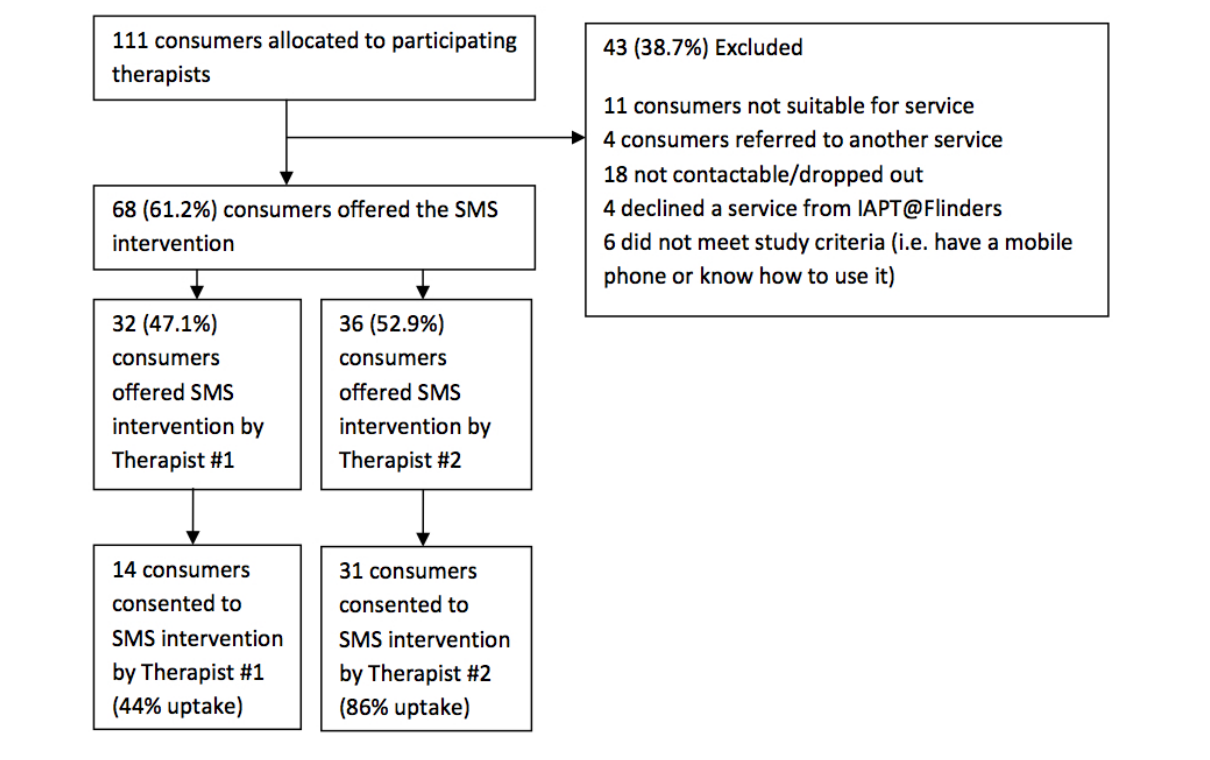
Figure 1. Flow of participants into the intervention